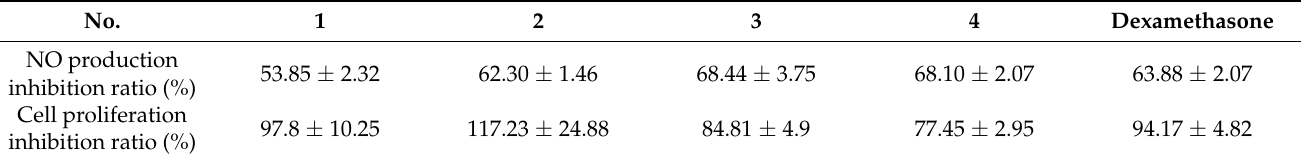
Table 3. The results of anti-inflammatory activities with concentration of 50 µ